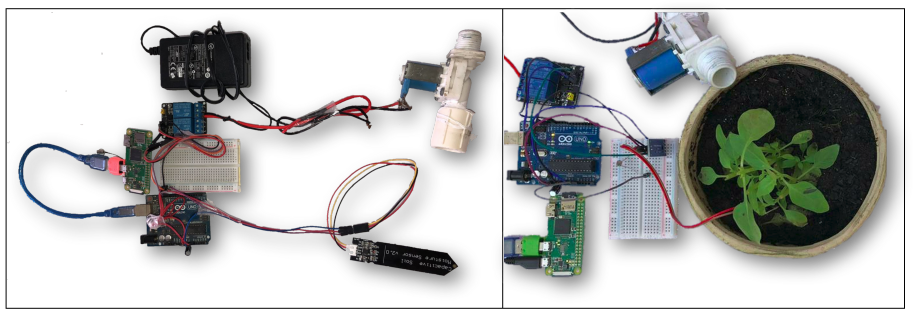
Figure 4. The IoT Object in the garden scenario is composed of an actuator for irrigation and sensors to measure soil’s pH level, soil moisture, luminous incidence, and